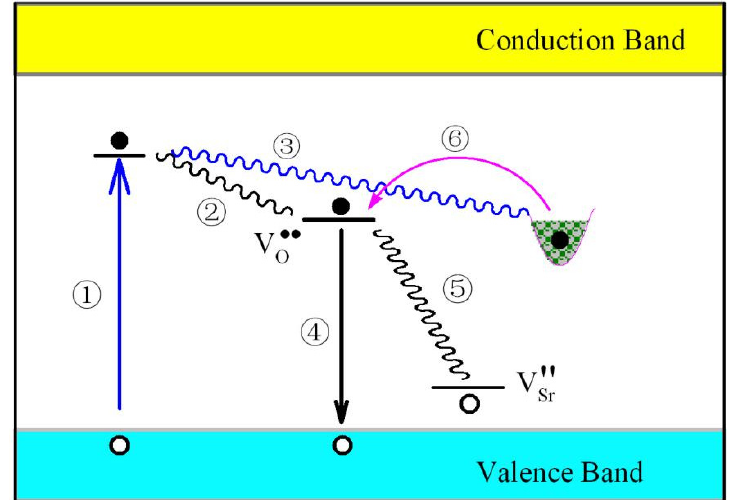
Figure 9. Schematic illustration of the PL and afterglow mechanisms of undoped SrAl 2 O 4 . Process ① : absorption of the excitation energy by intrinsic defects in SrAl 2 O 4 . Process ② : non-radiative relaxation of hot electrons to oxygen vacancies in SrAl 2 O 4 . Process ③ : non-radiative relaxation of hot electrons to electron traps (oxygen vacancies) in SrAl 2 O 4 . Process ④ : radiative recombination of electrons captured at oxygen vacancy with holes in the valence band of SrAl 2 O 4 , resulting in a broad PL band. Process ⑤ : radiative recombination of electrons captured at oxygen vacancies with holes captured at strontium vacancies, yielding another PL band. Process ⑥ : thermal release of electrons from electron traps in SrSO 4 , followed by radiative recombination via process ⑤ to yield the green afterglow.